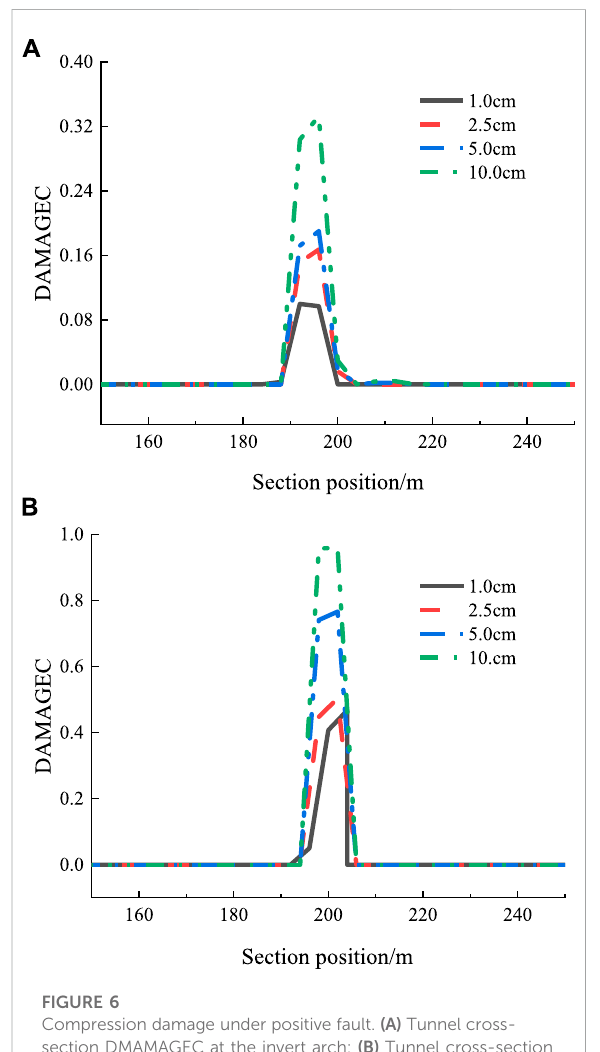
FIGURE 6 Compression damage under positive fault. (A) Tunnel cross- section DMAMAGEC at the invert arch; (B) Tunnel cross-section DAMAGEC at the arch waist.